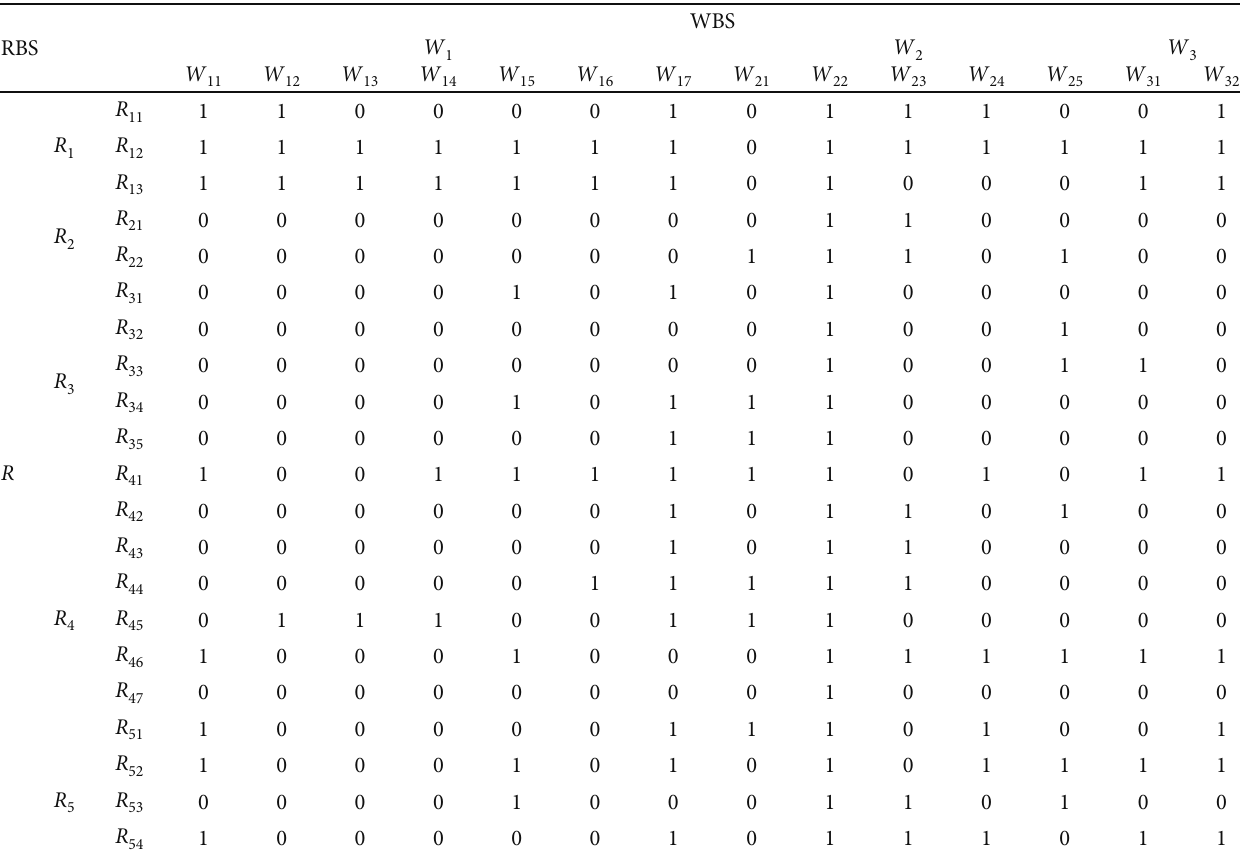
Table 3: WBS-RBS coupling